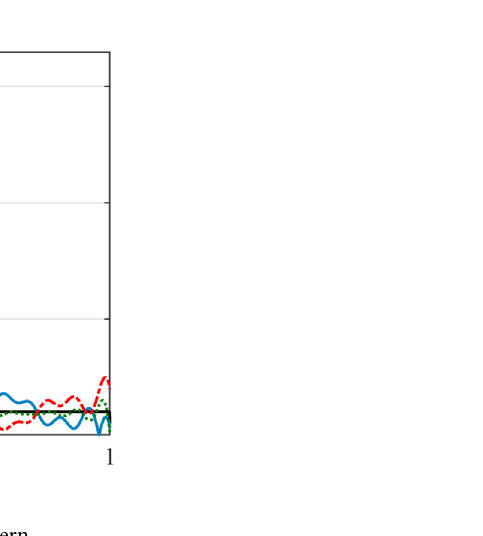
Figure 4. The synthesized results of the flat-top